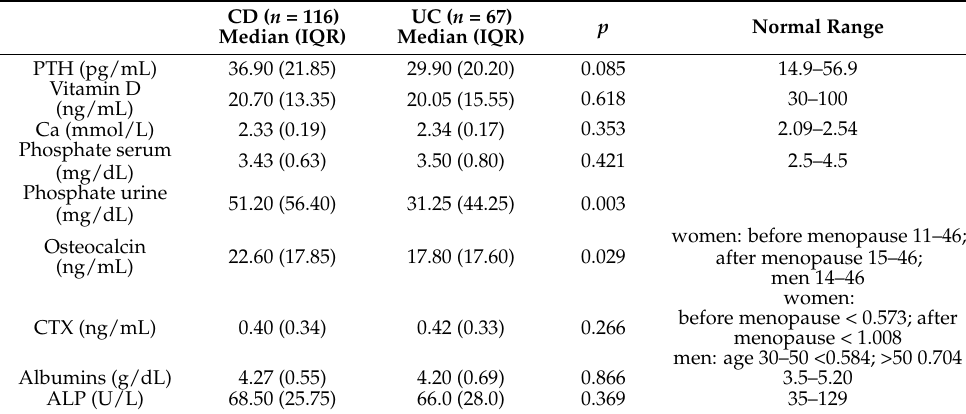
Table 3. Biochemical markers of bone metabolism in patients with Crohn’s disease and ulcerative colitis.